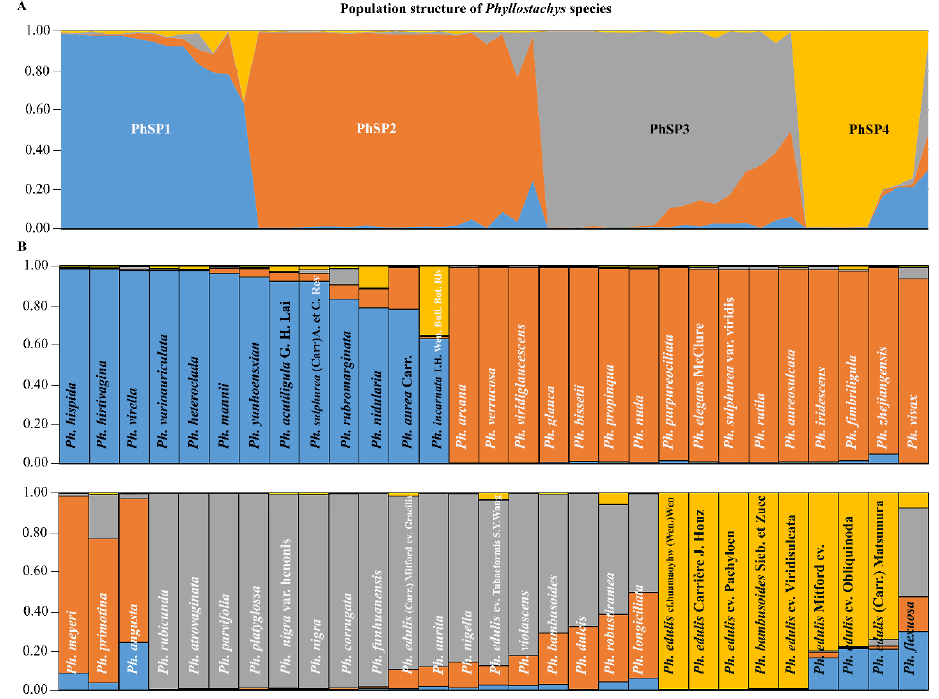
Figure 8. The population structure of 58 Phyllostachys species (Asian bamboo)-based inter-retrotransposon amplified polymorphism (IRAP) markers based on the Bayesian model. ( A ), Bar plot of sub-populations; ( B ), Accession based bar-plots indicating the members of different sub-populations showing the proportion of admixture of alleles. The different colors represent different sub-populations. The scale shows the inferred ancestry coefficients. Table 3. Description of consensual Asian bamboo accessions picked out from the groupings obtained from dendrogram and principal component analysis (PCA) with respect to deduced population structure based on inter-retrotransposon amplified polymorphism (IRAP). There were a total of 54 accessions falling under different sub-populations, PhSP1 to PhSP4.